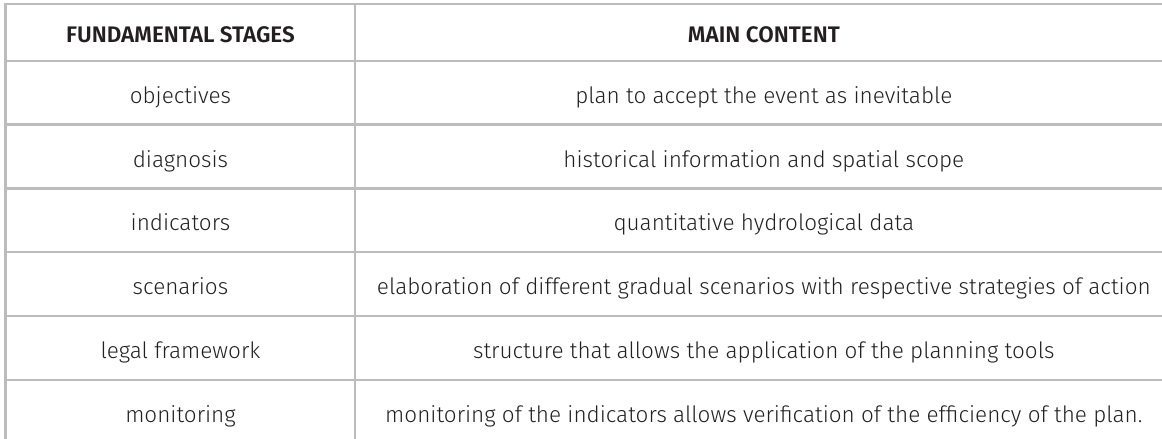
Table IV. Results of the comparison between the procedures of the Flood Risk Management Plan and the Special Plan for Alerting and Eventual Droughts in the Júcar Basin (source: prepared by the author). FUNDAMENTAL